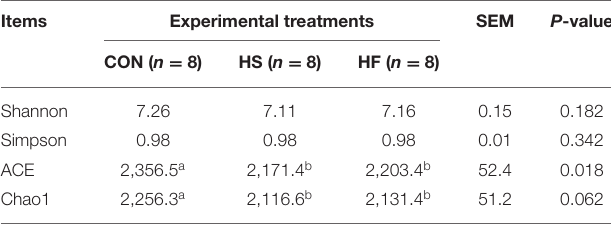
TABLE 5 | Effects of honeycomb flavonoids supplement on α -diversity of ruminal microbiota during heat stress